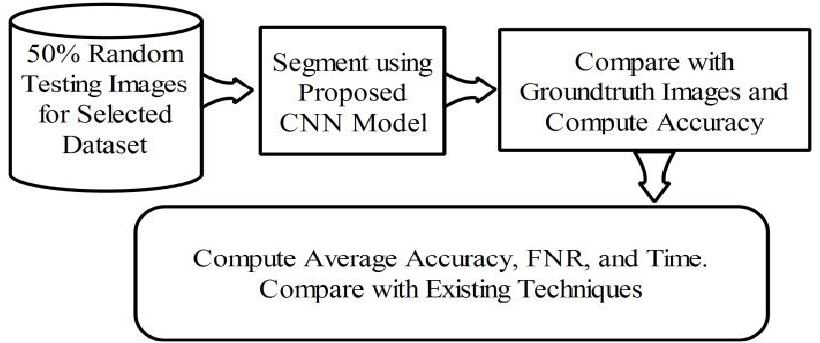
Figure 17. Evaluation of lesion segmentation performance without using contrast stretching step. Table 2. Lesion segmentation accuracy without employing contrast enhancement approach.